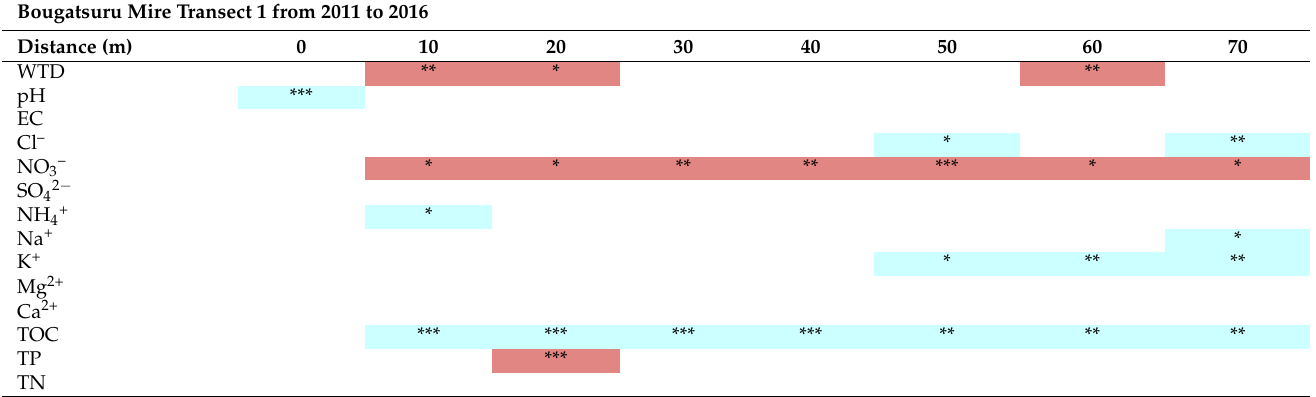
Table 5. Significance levels of regression of water environmental variables and elapsed days in Bougatsuru transect 1 (BGT transect 1) from 2011 to 2016. Red-colored cells mean significant positive slopes and blue-colored cells mean significant negative